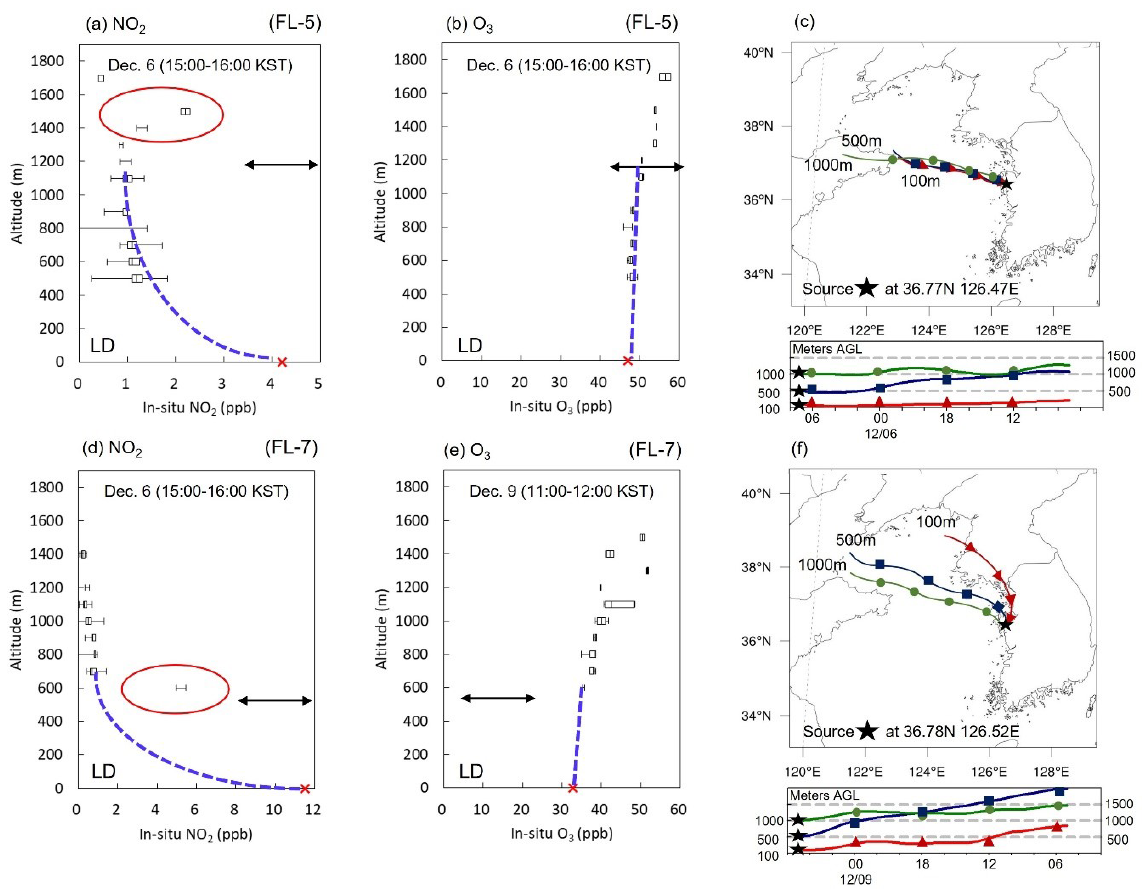
Figure 7. Box and whisker plots of the vertical NO 2 and O 3 profiles measured by GMAP aircraft superposed with in situ AQMS 1 mea- surements during flights (a, b) FL-5 (6 December) and (d, e) FL-7 (6 and 9 December). Blue dashed lines are linear regression lines fitted to NO 2 and O 3 profiles within the planetary boundary layer (PBL). Black arrows indicate the simulated PBL height (PBLH) obtained from the Korea Meteorological Administration (KMA). HYSPLIT 24h backward trajectories in Seosan are shown at altitudes of 100, 500, and 1000m, starting at 16:00KST on 26 November and 12:00KST on 12